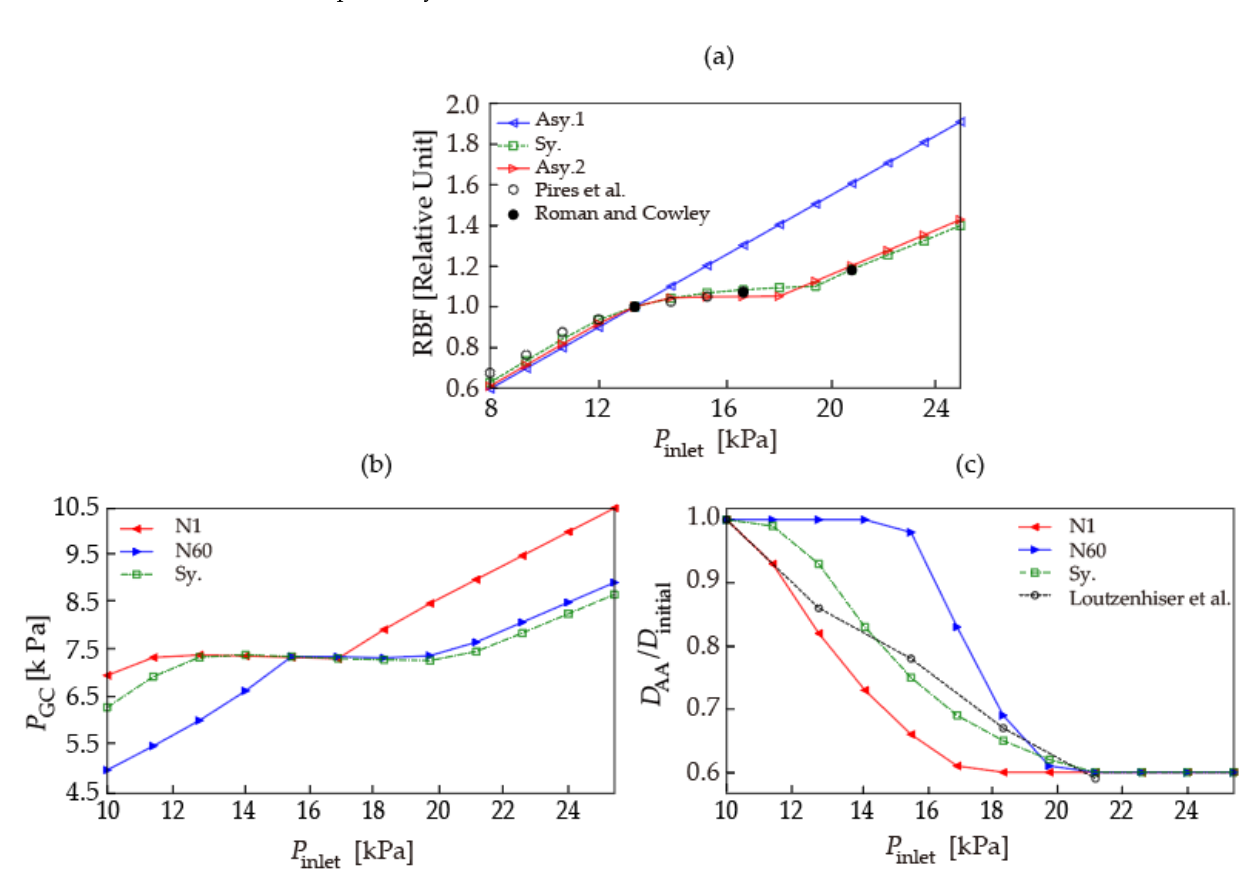
Figure 5. ( a ) Total renal flow rate Q inlet / Q 1 as a function of inlet pressure P inlet , where Q 1 is the flow rate at P inlet = 12.0 kPa. ( b ) Glomerular pressure, P GC and ( c ) rate-of-change of AA diameter Q AA of N1 (red left triangles) and N60 (blue right triangles) of the asymmetrical model, as well as the symmetrical model (green squares), as a function of P inlet . Experimental measurements are also illustrated in ( a ): Figure 1 from Pires et al. [36] (black open circles) and Figure 3 from Roman and Cowley [37] (black closed circles); in ( c ), Figure 3 from Loutzenhiser et al. [39].